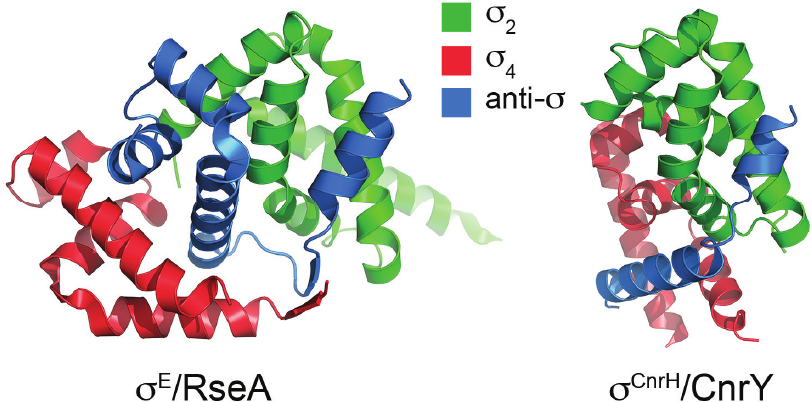
Figure 3. The inhibition of (cid:2) activity by anti-(cid:2) factors. A comparison between complexes of (cid:2) E -RseA (PDB: 1OR7-2) and a (cid:2) CnrH /CnrY/ (PDB: 4CXF). The (cid:2) 2 and (cid:2) 4 domains are colored green and red, respectively. The anti-sigma binding domains of RseA and CnrY are colored